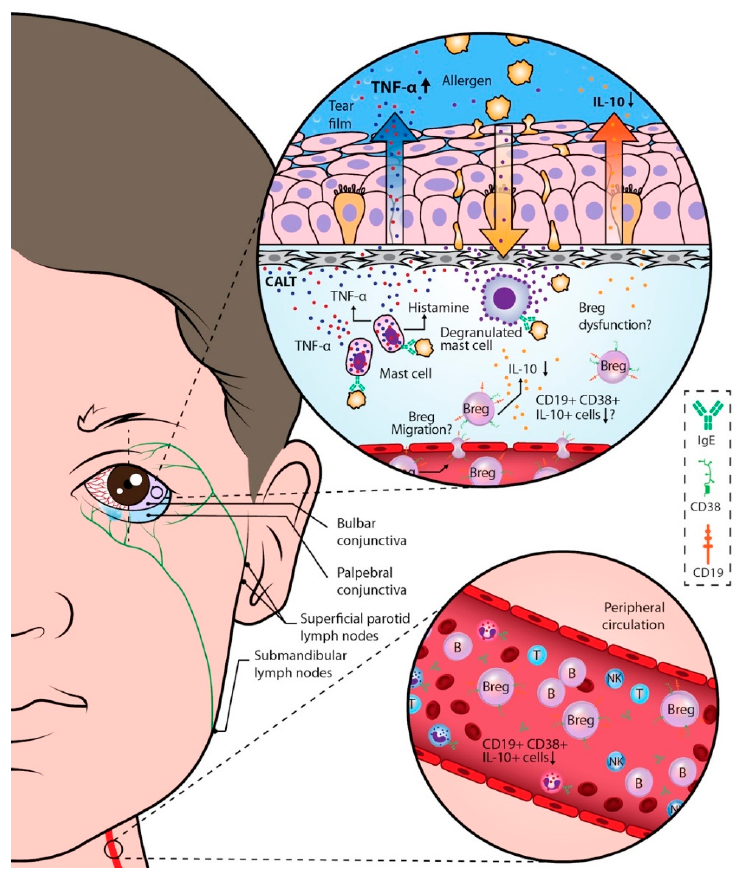
Figure 5. Systemic and local immune dysregulation observed in patients with perennial allergic conjunctivitis (PAC). The immune dysregulation in PAC is characterized by the low expression of IL-